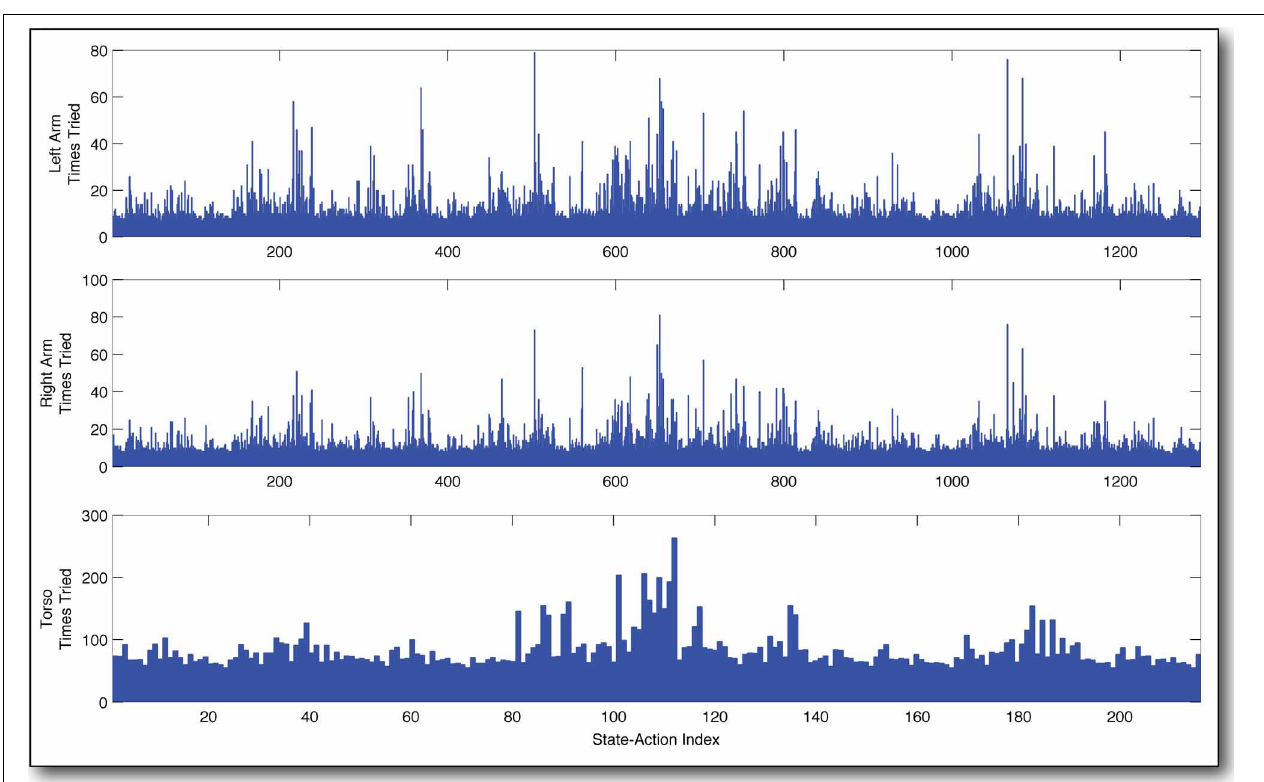
FIGURE 10 | Frequency of actions taken by three curious agents in parallel. The most interesting actions are selected much more often than the others. They correspond to moving the arm down and